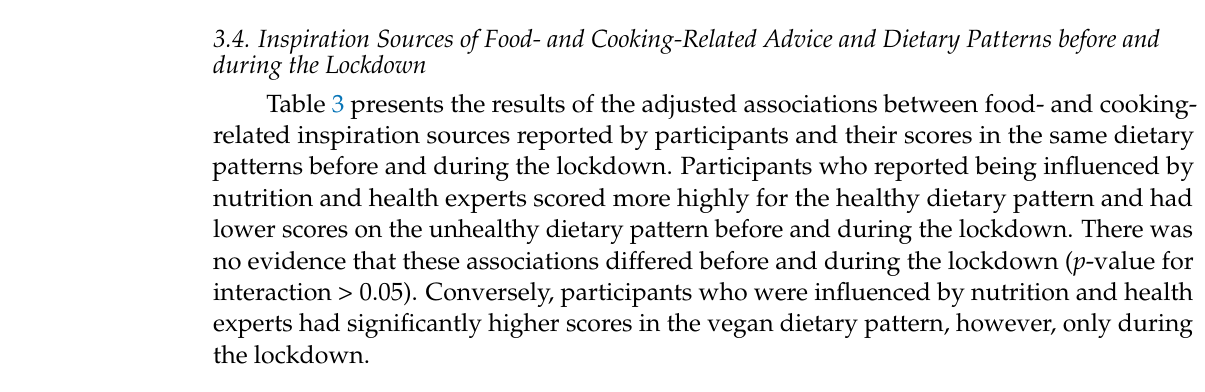
Table 3. Adjusted associations between food- and cooking-related inspiration sources and scores in the dietary patterns before and during the lockdown ( n =